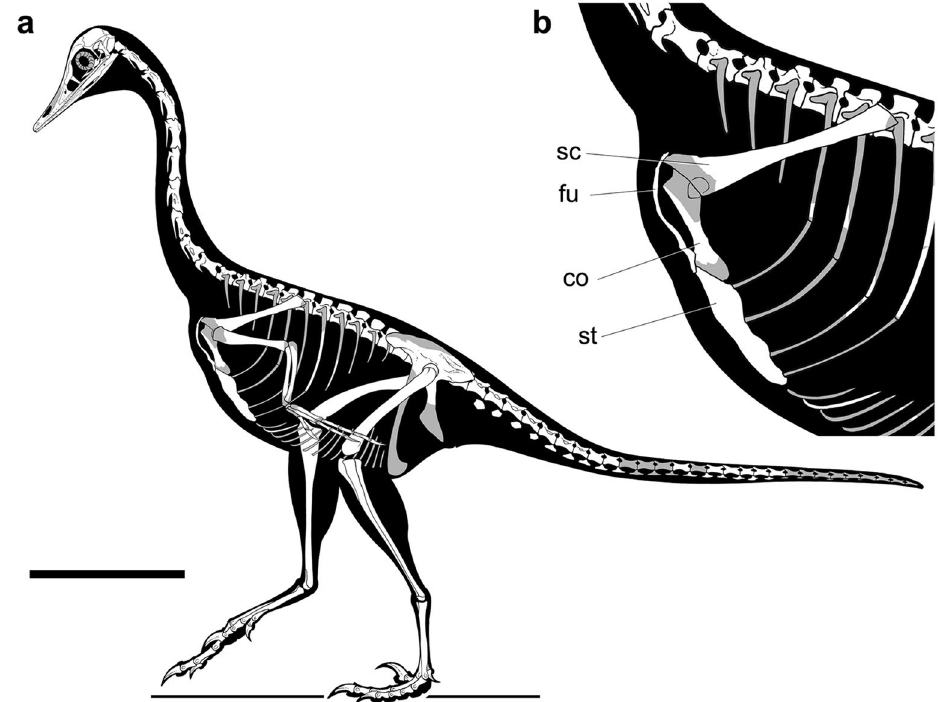
Figure 4. Updated reconstruction of the skeleton of H. escuilliei . ( a ) Whole skeleton in left lateral view; ( b ) detail of the pectoral apparatus (left forelimb removed). Missing elements indicated in grey. co coracoid, fu furcula, sc scapula, st sternum. Scale bar: 10 cm. Drawing by M.